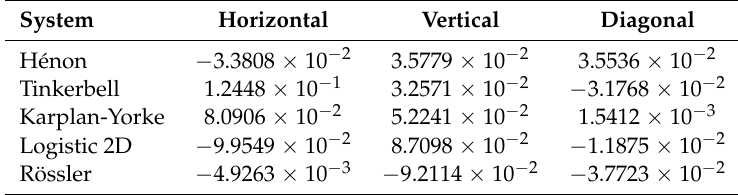
Table 8. Correlation coefficients of the Cameraman’s cryptogram.